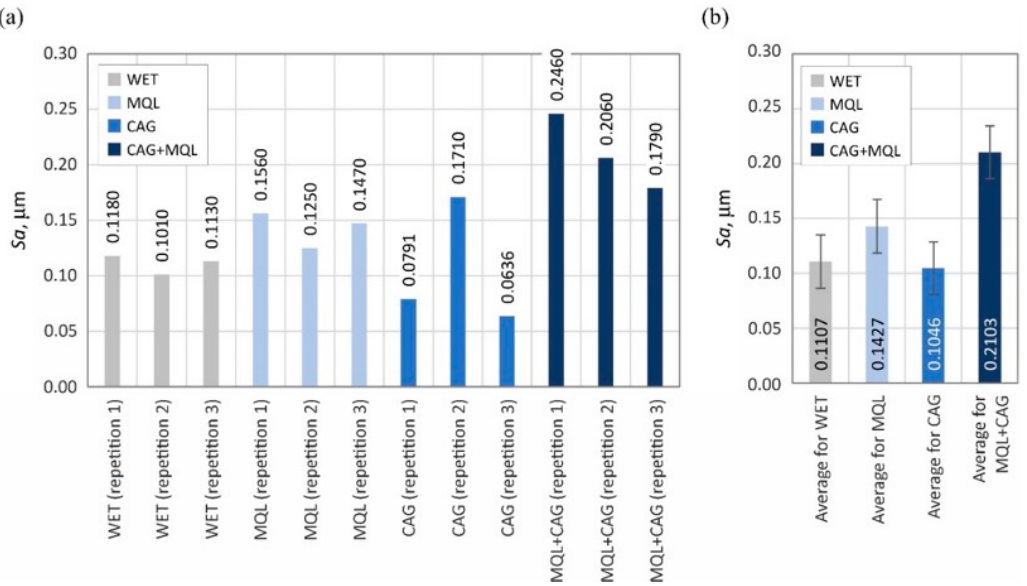
Figure 7. Chart of changes in the arithmetic mean deviation of the surface Sa : ( a ) results for the twelve blades selected for the surface texture measurements; ( b ) mean values of the parameters divided by cooling and lubrication methods of the grinding zone used during the shaping of the blades (error bars represent the standard error equal to the standard deviation σ divided by the square root of the total number of samples).